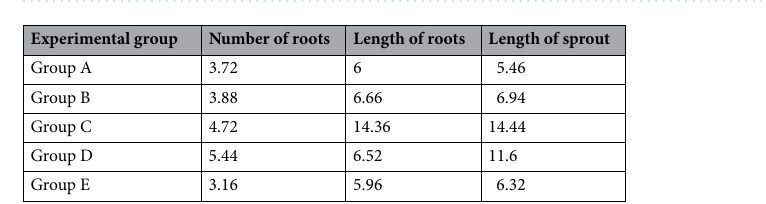
Table 1. The average value of number of roots, length of roots and length of the sprout in the experimental groups.